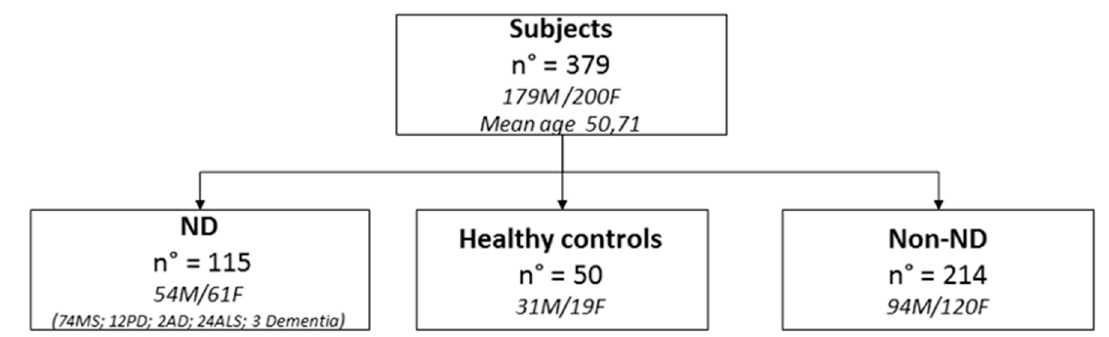
Figure 1. Characteristics of enrolled subjects. ND: neurogenerative diseases, MS: multiple sclerosis, AD: Alzheimer’s disease, and ALS: amyotrophic lateral sclerosis.